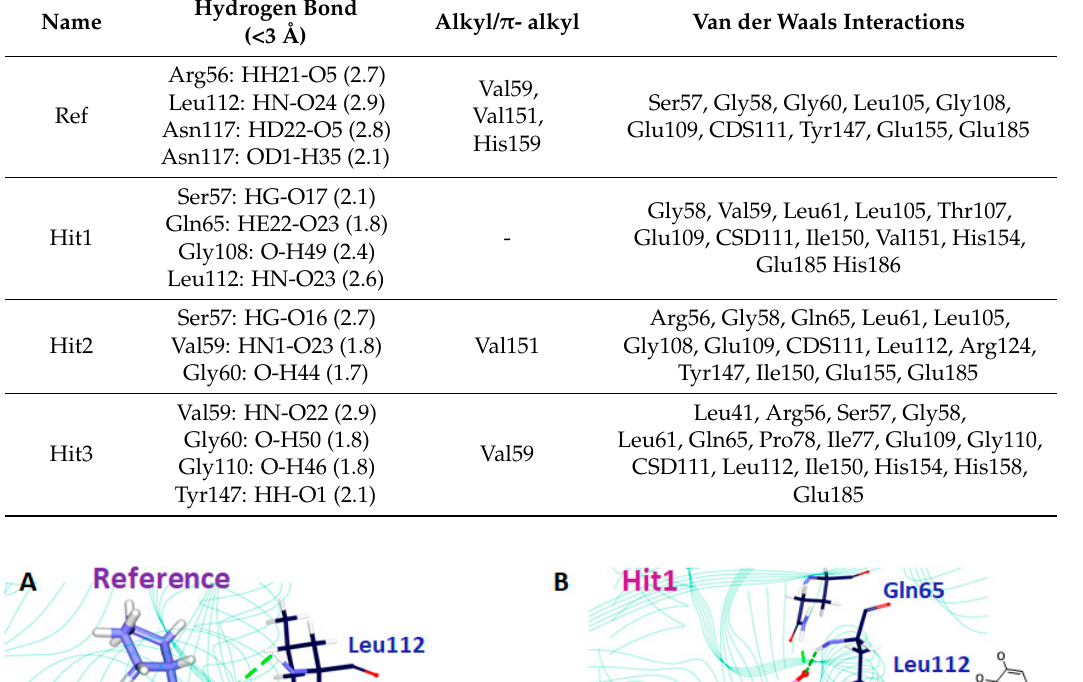
Table 7. Intermolecular molecular interactions between the proteins and the hits.